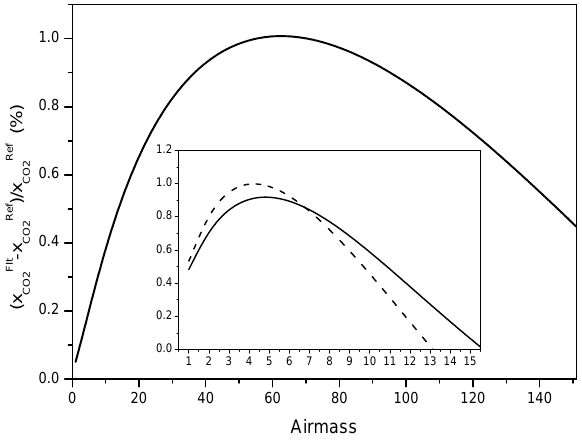
Fig. 4. Relative errors in the CO 2 vmrs deduced from fits, neglect- ing line-mixing effects, of spectra with a 50cm MOPD for vari- Figure 4. Relative errors in the CO 2 vmrs deduced from fits, neglecting line-mixing effects, of ous airmasses. The main plot gives results obtained in Band#2. In spectra with a 50 cm MOPD for various airmasses. The main plot gives results obtained in the insert can be compared results obtained in Band#1 (full line) Band#2. In the insert can be compared results obtained in Band#1 ( ___ ) with those obtained with those obtained in Band#2 (dashed line) after multiplying the in Band#2 ( _ _ _ ) after multiplying the Band#2 line intensities by 15. Band#2 line intensities by